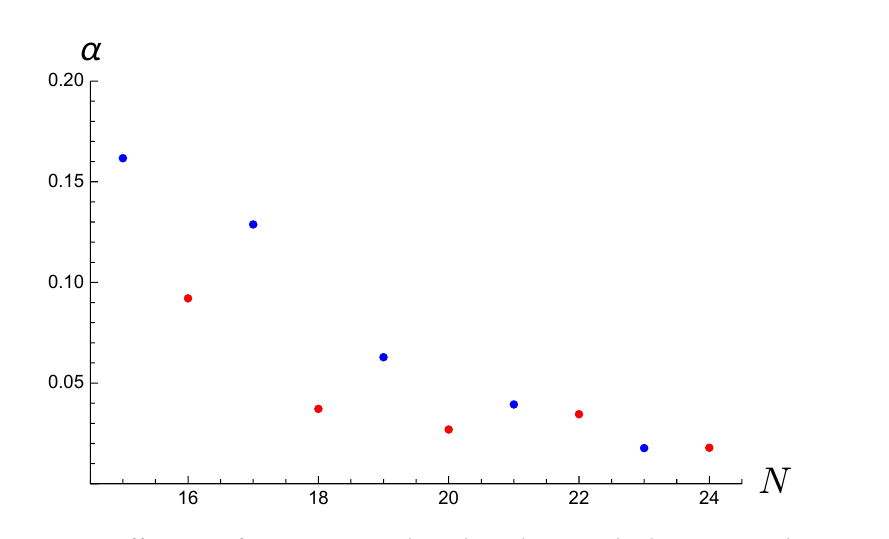
Figure 9: Fit coefficient α for increasing chain lengths N in the lowest strictly positive S z and k = 2 π/ N sectors. Blue dots have odd N and S z T = N and S z T